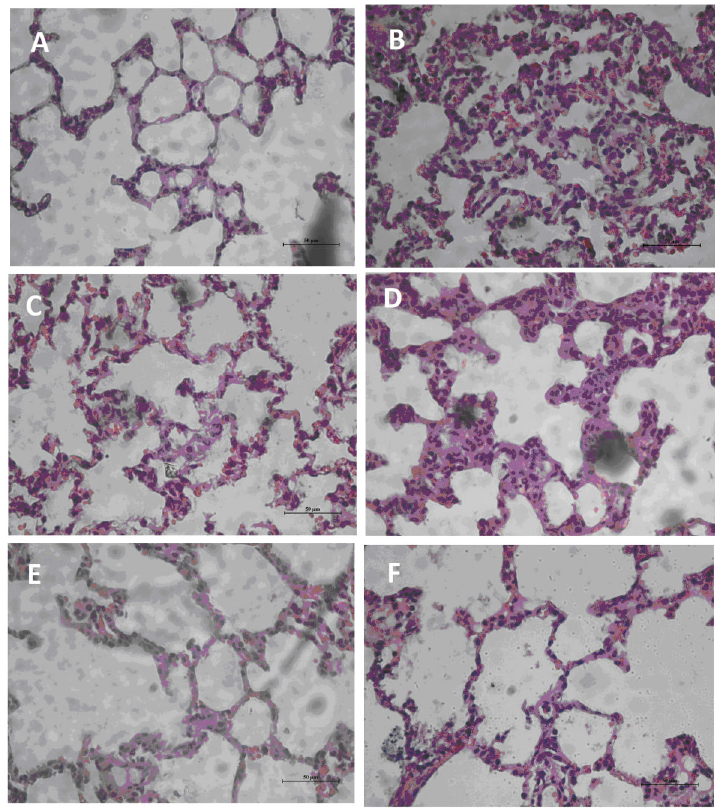
rats. As shown in Figure 2, lung W/D ratio and levels of proteins, TNF- a , and IL-6 in BALF was significantly higher in the LPS group than in the control group (P , 0.001, n=6 animals per group); however, there were no significant differences of W/D ratio, concentration of proteins, TNF- a , and IL-6 in BALF among the control, propofol, and wortmannin groups. Propofol pretreatment significantly decreased the W/D ratio and the concentration of proteins, TNF- a , and IL-6 in BALF caused by LPS injection, while treatment with wortmannin partially blunted the effect of propofol pretreatment (values of P from 0.05 to 0.01, n=6 animals per group).